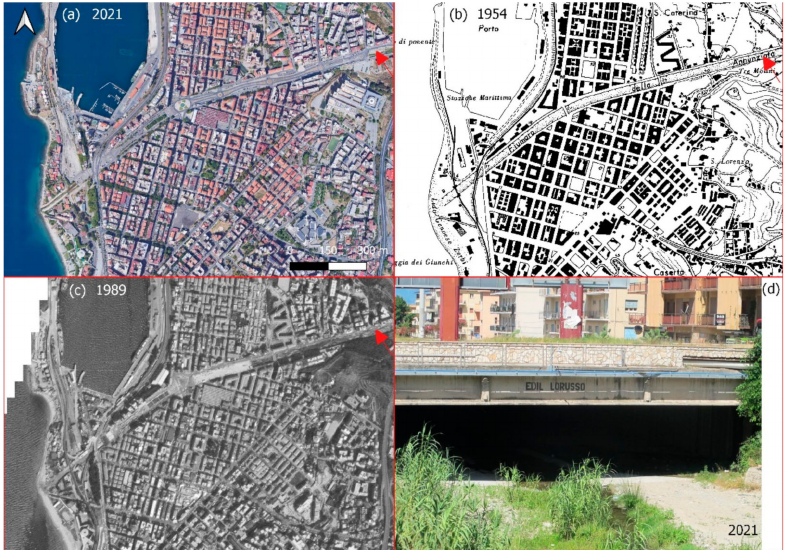
Figure 8. The Annunziata River. ( a ) An image from Google Earth from September 2021. ( b ) The CASMEZ cartography from 1954. ( c ) The orthophoto from 1989. ( d ) The detail of the culvert (view from the mountain to the valley). The arrows identify the upstream section of the culvert.